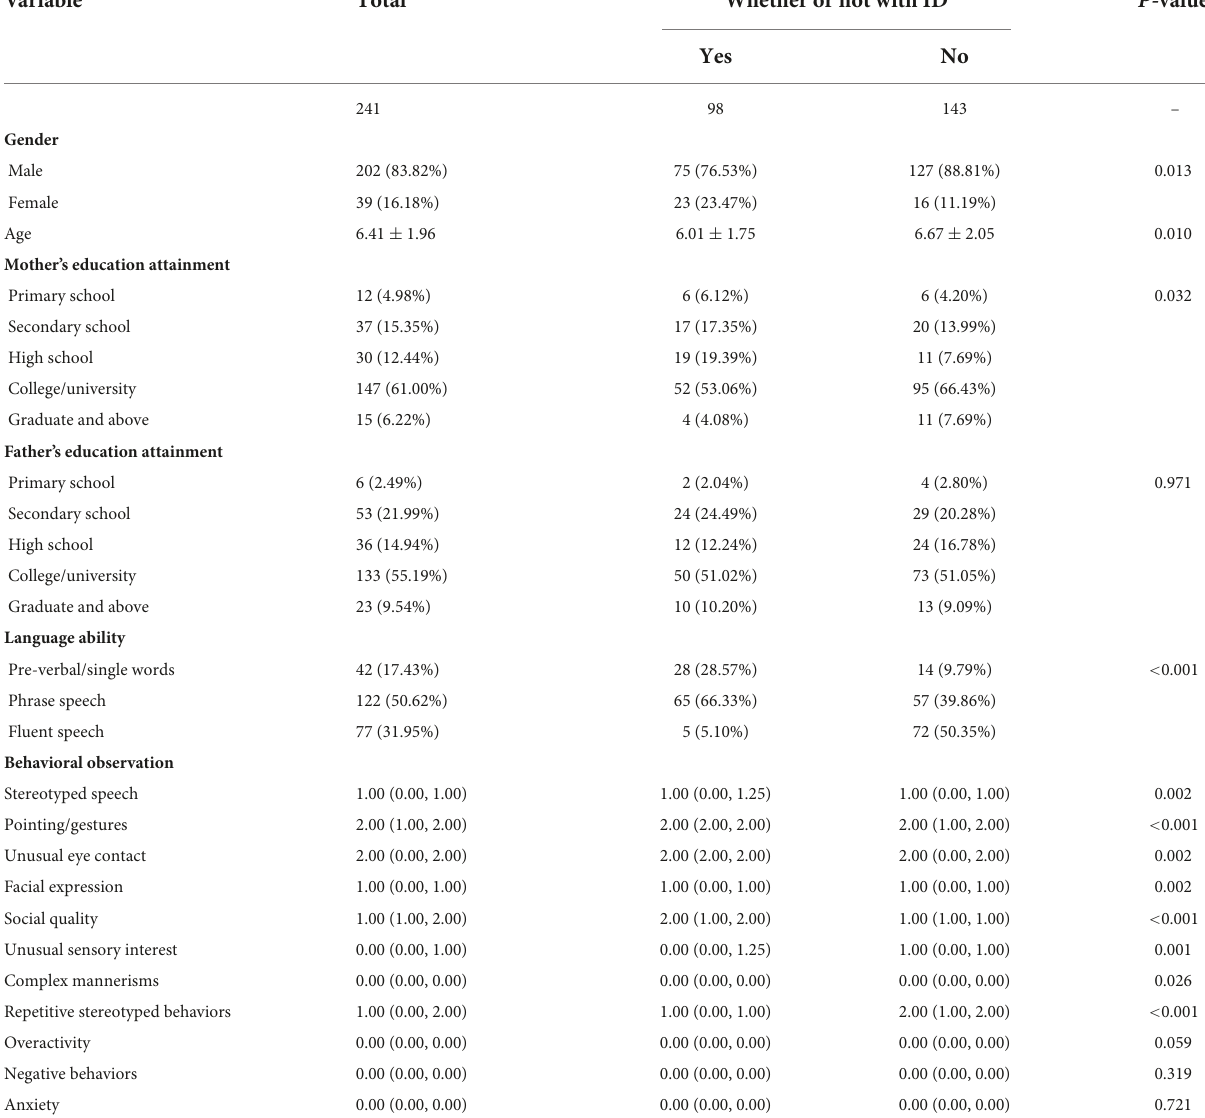
TABLE 2 The socio-demographic information and behavioral observations of autistic children.